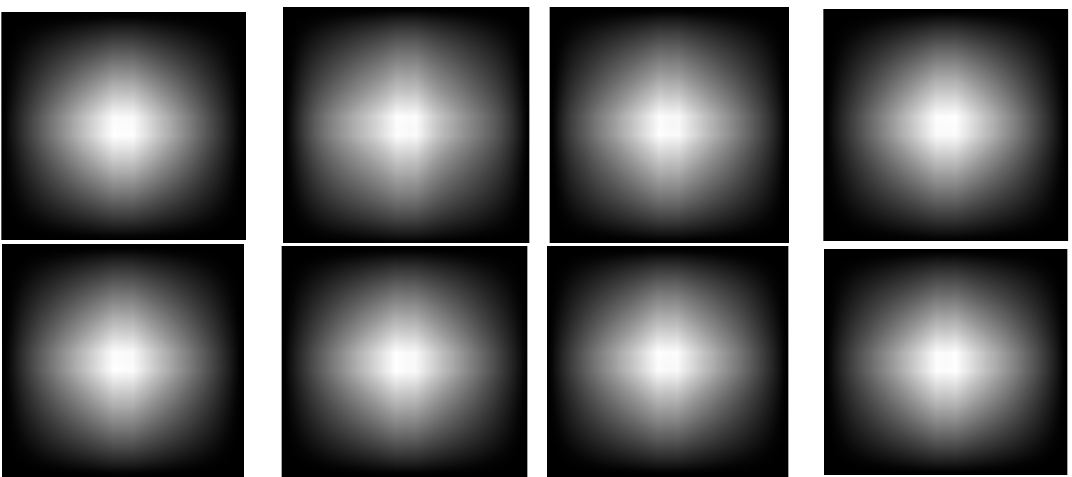
Figure 12. Equivalent kernel samples of encrypted training fingerprints.